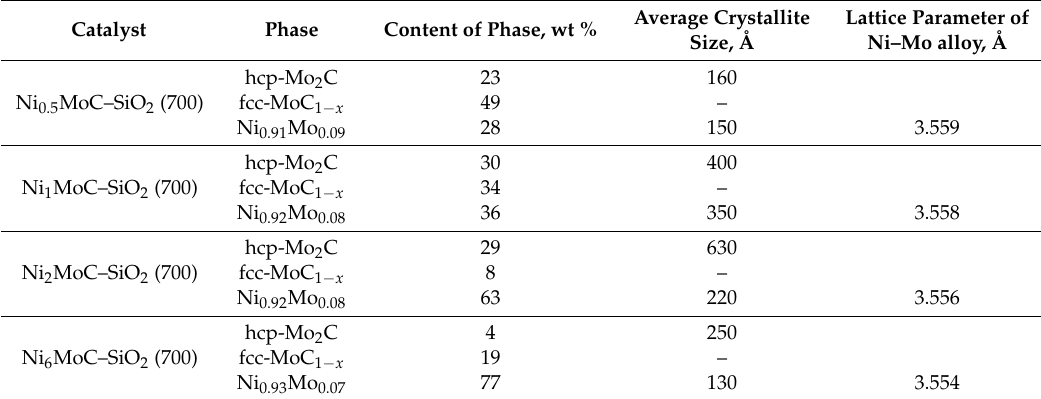
Table 3. Phase composition of the calcined Ni x MoC–SiO 2 (700) catalysts.